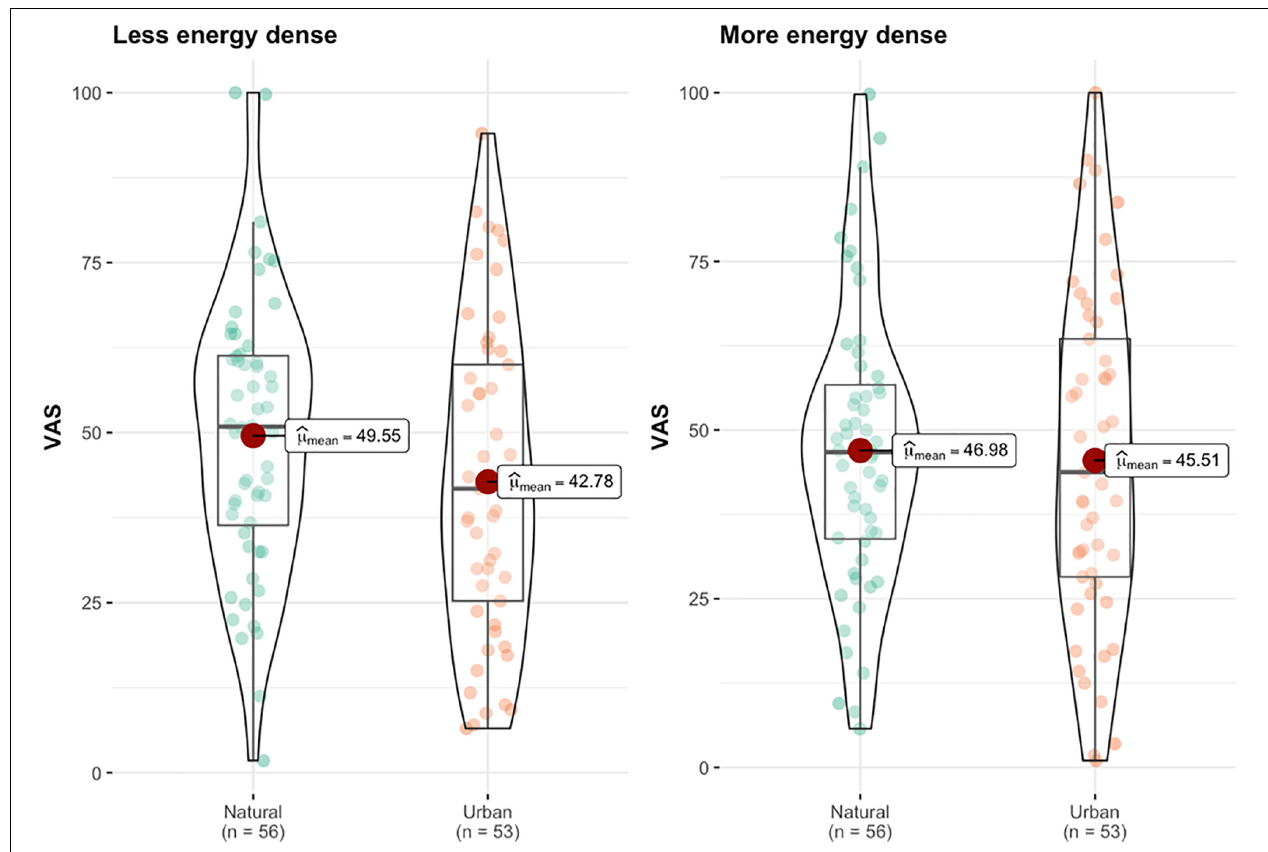
FIGURE 2 | Mean differences in preference for less energy-dense (fruit and vegetables) and more energy-dense foods, measured on a 100 mm Visual Analog Scale (VAS), across experimental condition (natural vs.